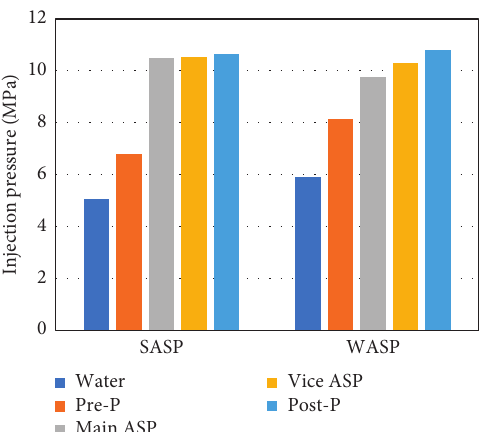
Figure 9: Injection pressure in different stages [41].